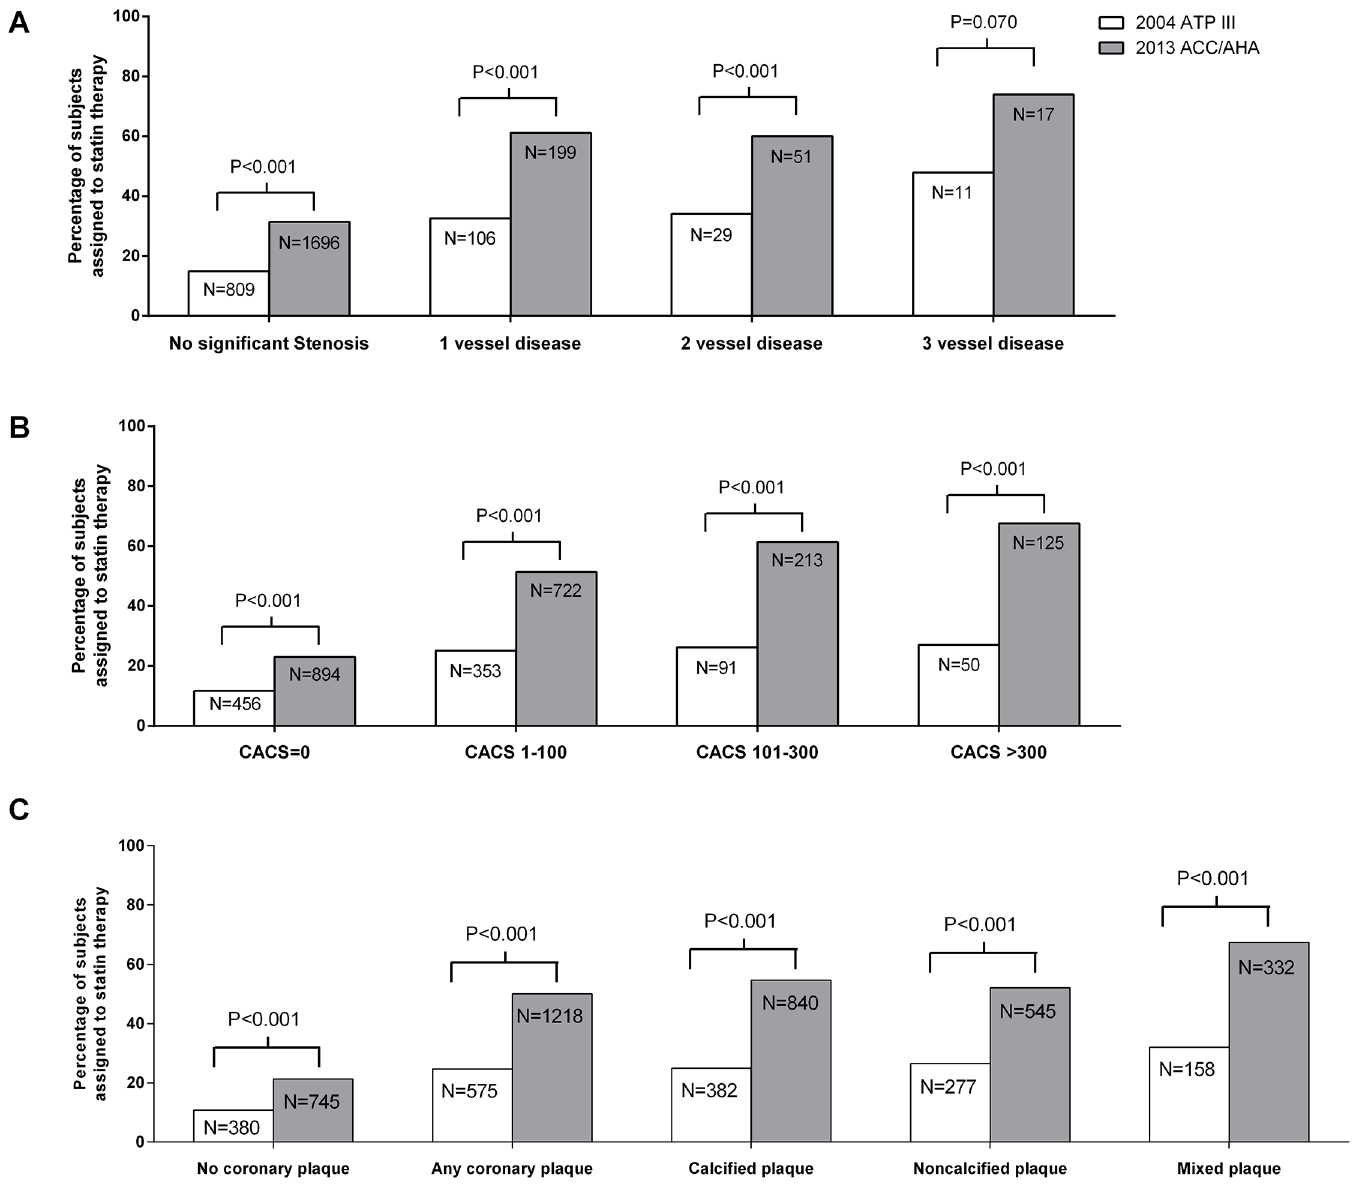
Fig 1. Differences between 2004 ATP III and 2013 ACC/AHA guideline on statin recommendation according to coronary atherosclerosis. Percentage of subjects with or without significant coronary artery stenosis (A), coronary artery calcium score (CACS) of 0, 1 – 100, 101 – 300, and > 300 (B), coronary plaque (C), who were recommended statin therapy according to 2004 ATP III versus 2013 ACC/AHA